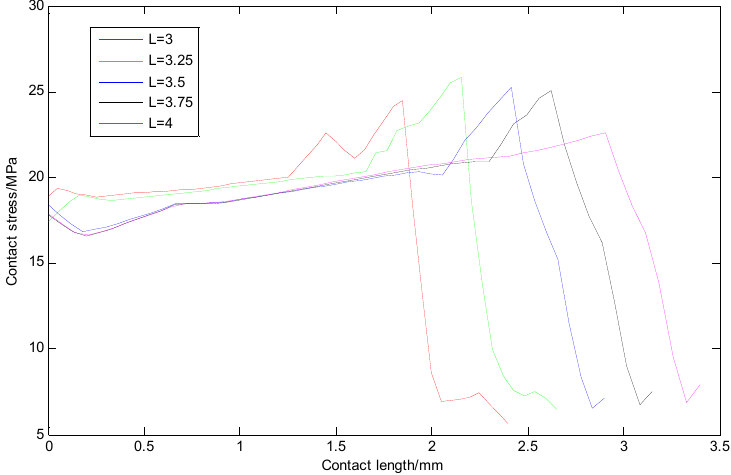
Figure 8. Distribution of contact stress along the contact path at I at different widths L (mm).